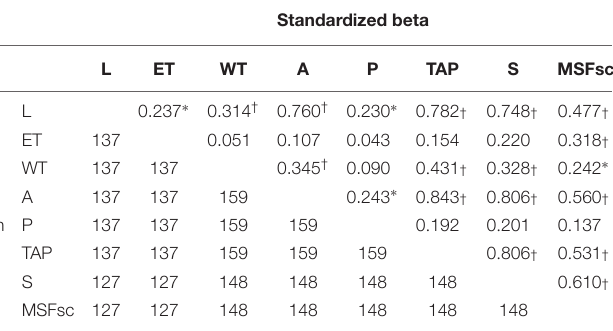
Values of the upper triangular matrix are beta-standardized coefficients calculated by a regression analysis controlled for gender and age with Bonferroni correction ( ∗ p < 0.007; † p < 0.001). The lower triangular matrix shows the sample size for the corresponding regression analysis. Abbreviations: L, light exposure; ET, environmental temperature; WT, wrist temperature; A, activity; P, position; TAP, integrated variable integrated by WT, A, and P; S, sleep